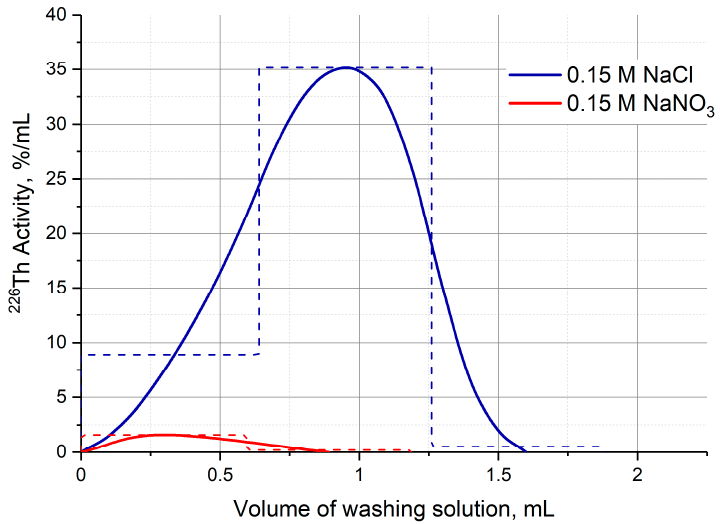
Figure 10. 226 Th losses during the substitution of the 7 M HCl medium on the UTEVA resin column with neutral salt solutions.